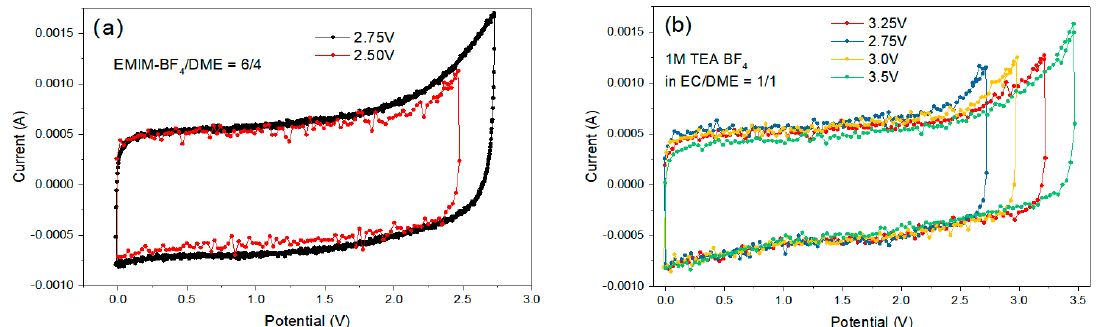
Figure 13. Cycling voltammetry curves of electrical double layer capacitors (EDLC) cells with formulations ( a ) #1, EMIM-BF4/DME = 6/4 v / v ; ( b ) #7, 1M TEA-BF4 EC/DME = 1/1 v / v .